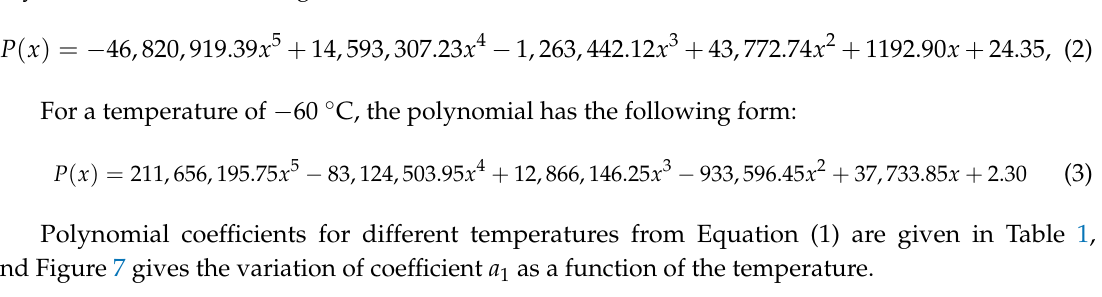
Table 1. Polynomial coefficients for different temperatures.